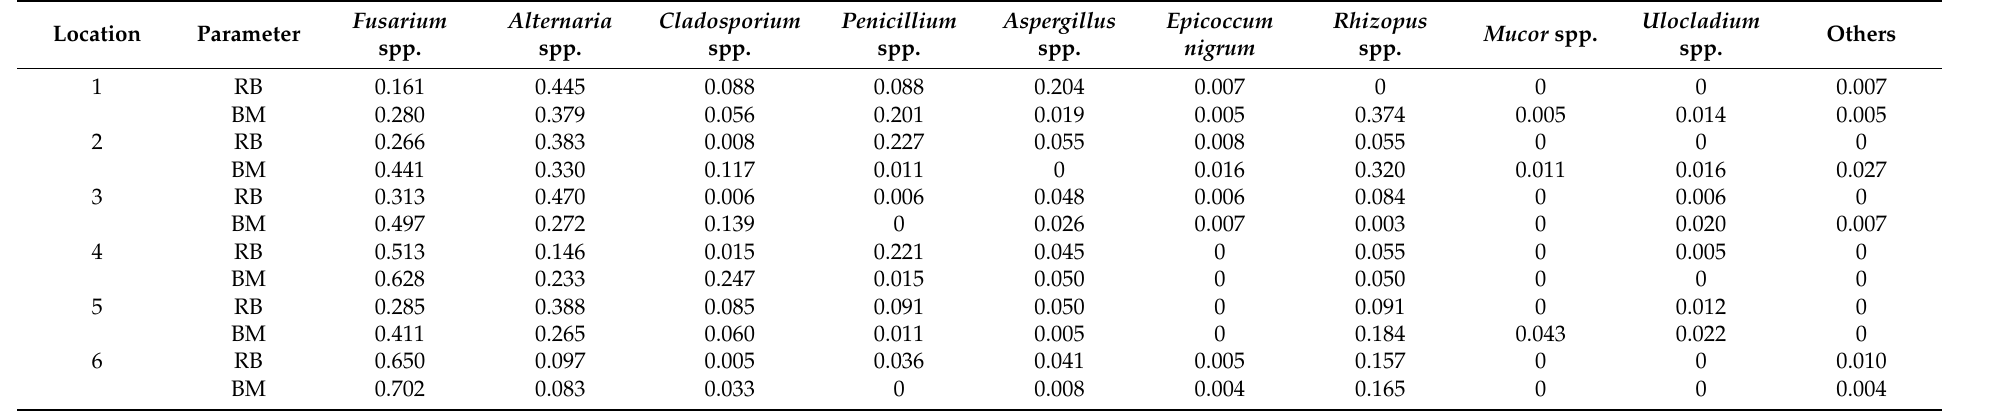
Table 3. Impact of the proveniences on the fungal spectrum: relative abundance of fungal genera isolated from kernels of raw barley (RB) and the corresponding barley malt (BM) of six proveniences in Germany summarized over 4 harvest years (2018–2021); standardized malting procedure according to MEBAK raw